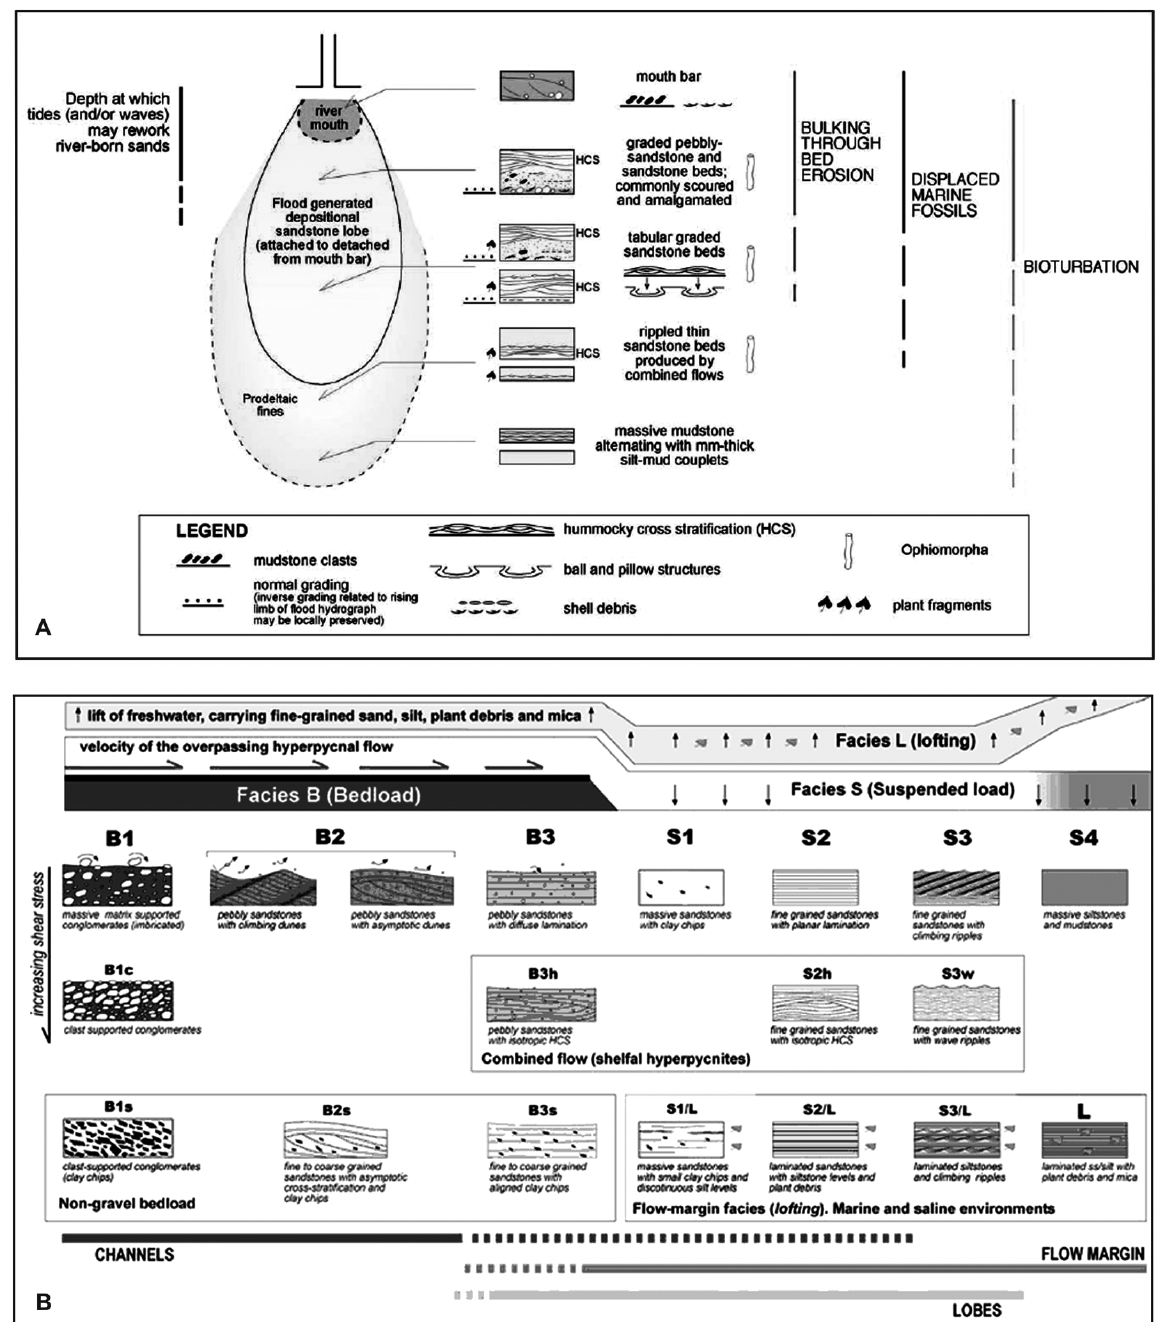
Fig. 2 – (A) Main characteristics of delta-front sandstone lobes in a flood-dominated fluvio-deltaic system (Mutti et al. 2007). (B) Schematic diagram showing the genetic interpretation of clastic facies in hyperpycnal systems (Zavala